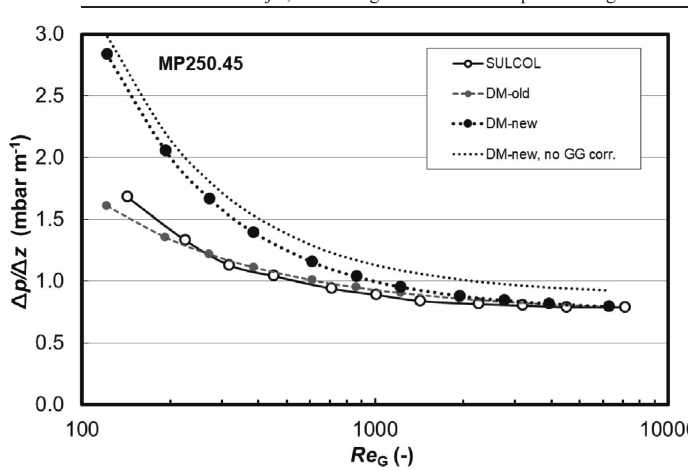
Fig. 9 – Specific pressure drop as estimated by original (DM-old) and extended DM (DM-new) for advanced corrugat- ed sheet structured packing (MP250.45) in conjunction with given hypothetical base case, compared with SULCOL esti- mates for MellapakPlus 252.Y